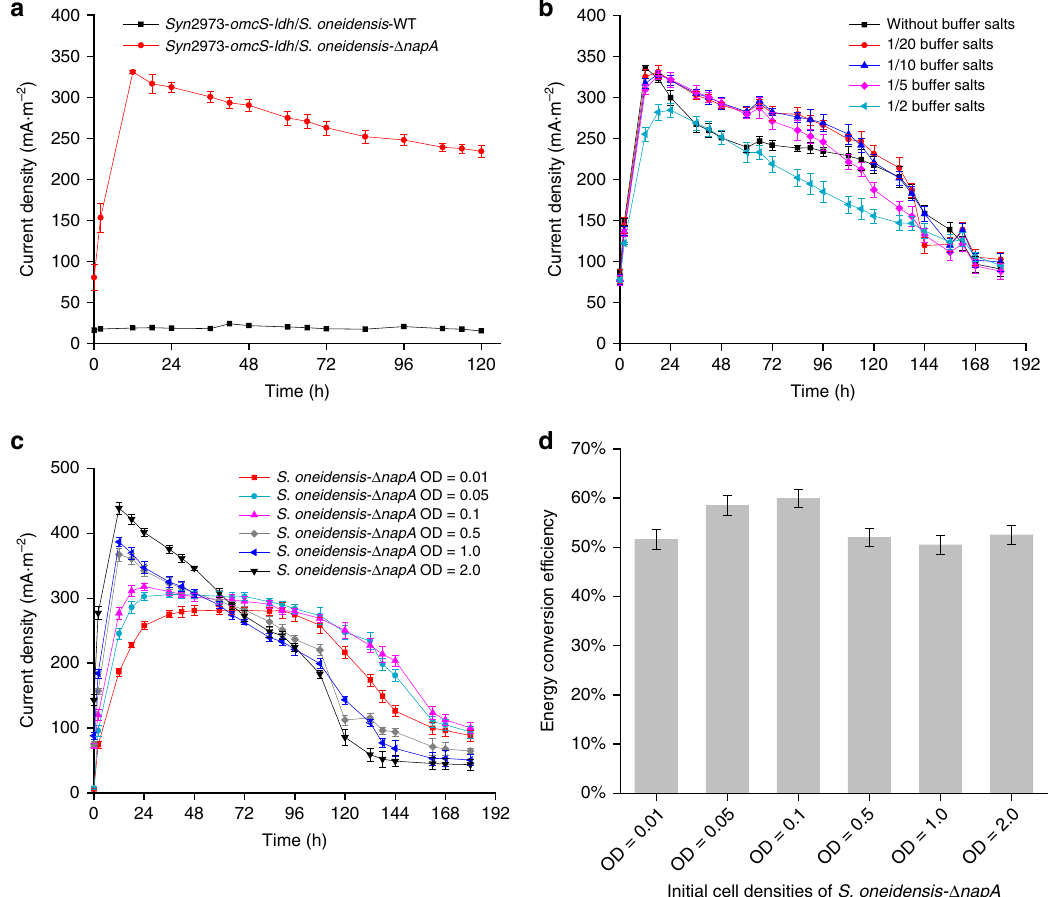
Fig. 3 Performance of the temporally separated CLS microbial consortium. a Current density produced by two microbial consortia comprising Syn 2973- omcS - ldh and S. oneidensis -WT or S. oneidensis- Δ napA , respectively. b The robustness of the CLS microbial consortium evaluated in MBG11 medium with different concentrations of buffer salts. c The robustness of the CLS microbial consortium evaluated by gradually reducing the inoculated cell density of S. oneidensis- Δ napA . d The energy conversion ef fi ciency ( D -lactate to electricity) of the CLS microbial consortium with different inoculated cell densities of S. oneidensis- Δ napA . All experimental setups were incubated in the dark. Error bars represent the standard deviations from n = 3 independent experiments. Source data are provided as a Source Data fi